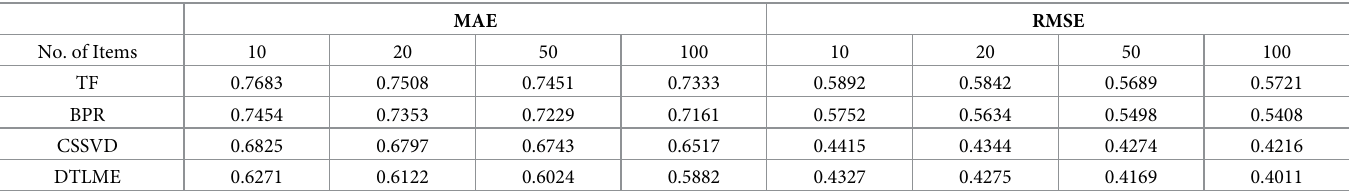
Table 6. Performance comparison for user cold-start problem on